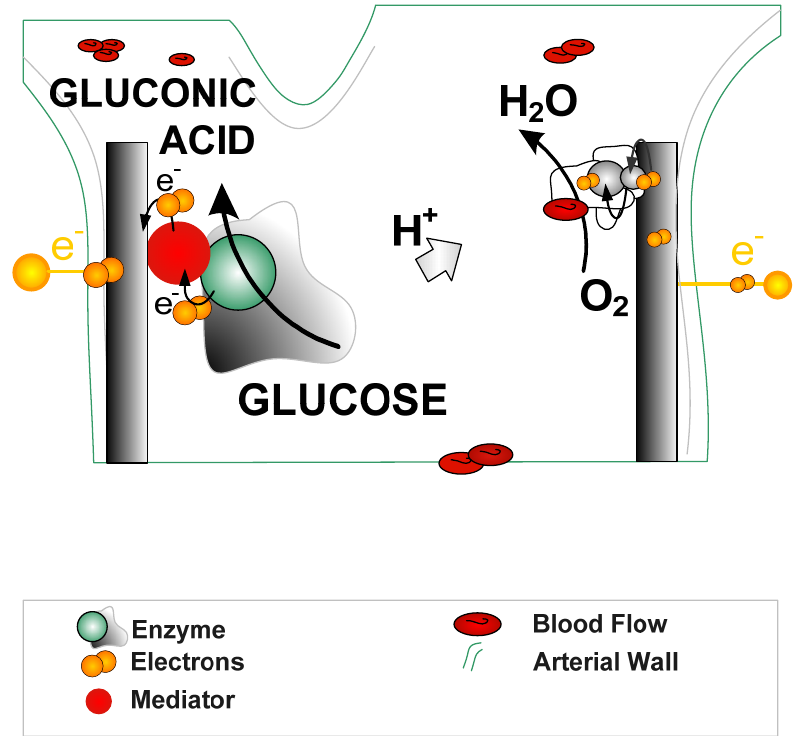
Figure 1. Schematic diagram of an enzymatic biofuel cell working in